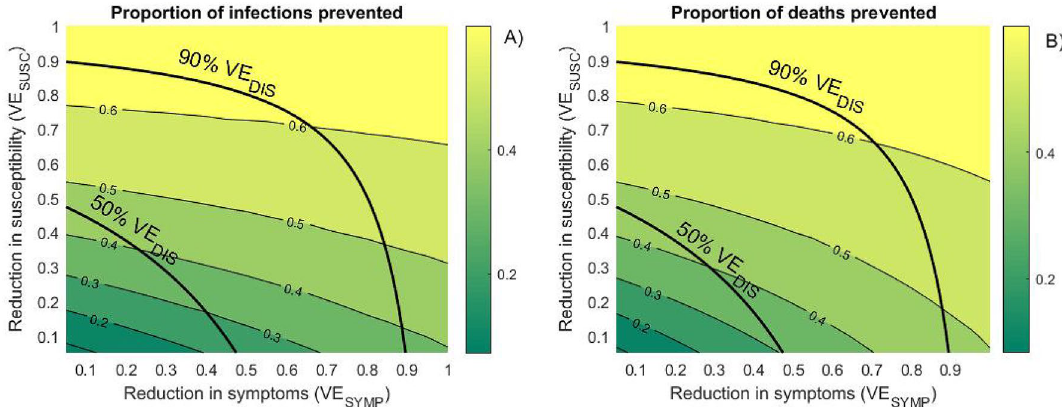
Figure 3. Projected vaccine effectiveness. Contour plots of the proportions of: ( A ) cumulative infections prevented and ( B ) cumulative deaths prevented over 1 year after the start of vaccine rollout by vaccines with different effects on susceptibility (VE SUSC ) and the risk to develop symptoms (VE SYMP ). Rollout assumes 5000 vaccinated daily till 1,000,000 vaccinations are reached. Thick lines represent VE profiles resulting in 50% and 90% reduction in symptomatic disease (VE DIS